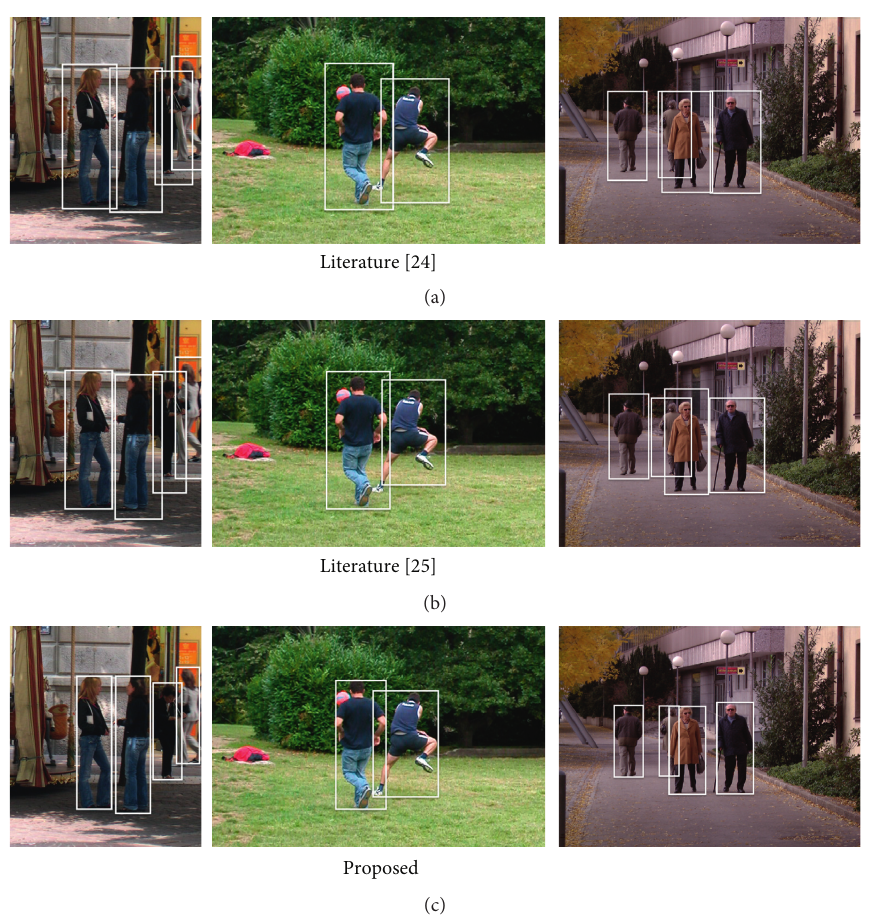
Figure 7: Comparison results during the day. (a) Literature [24]. (b) Literature [25]. (c) Proposed. Table 2: Comparison of detection results of different algorithms. Table 3: Performance comparison results of different AP (%) Methods Speed (frame/s) All day The day The night